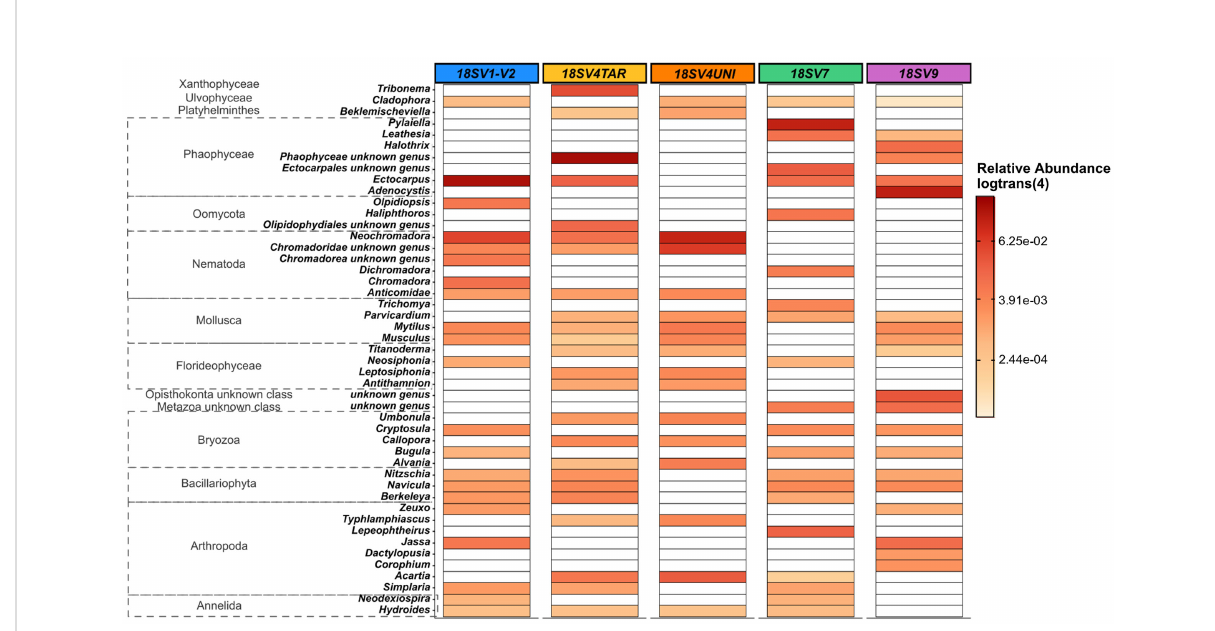
FIGURE 4 Heat map based on Toulon samples representing the relative abundance [in log_trans (4)] of: eukaryote genera speci fi c to each 18S rDNA primers (>0,3%). 37 common genera were removed to visualize only the speci fi c genera. Samples used are the three panels (PVC, PA, and HDPE) from Toulon extracted with the PMS method and ampli fi ed with fi ve hypervariable regions of 18S rDNA (n = 45